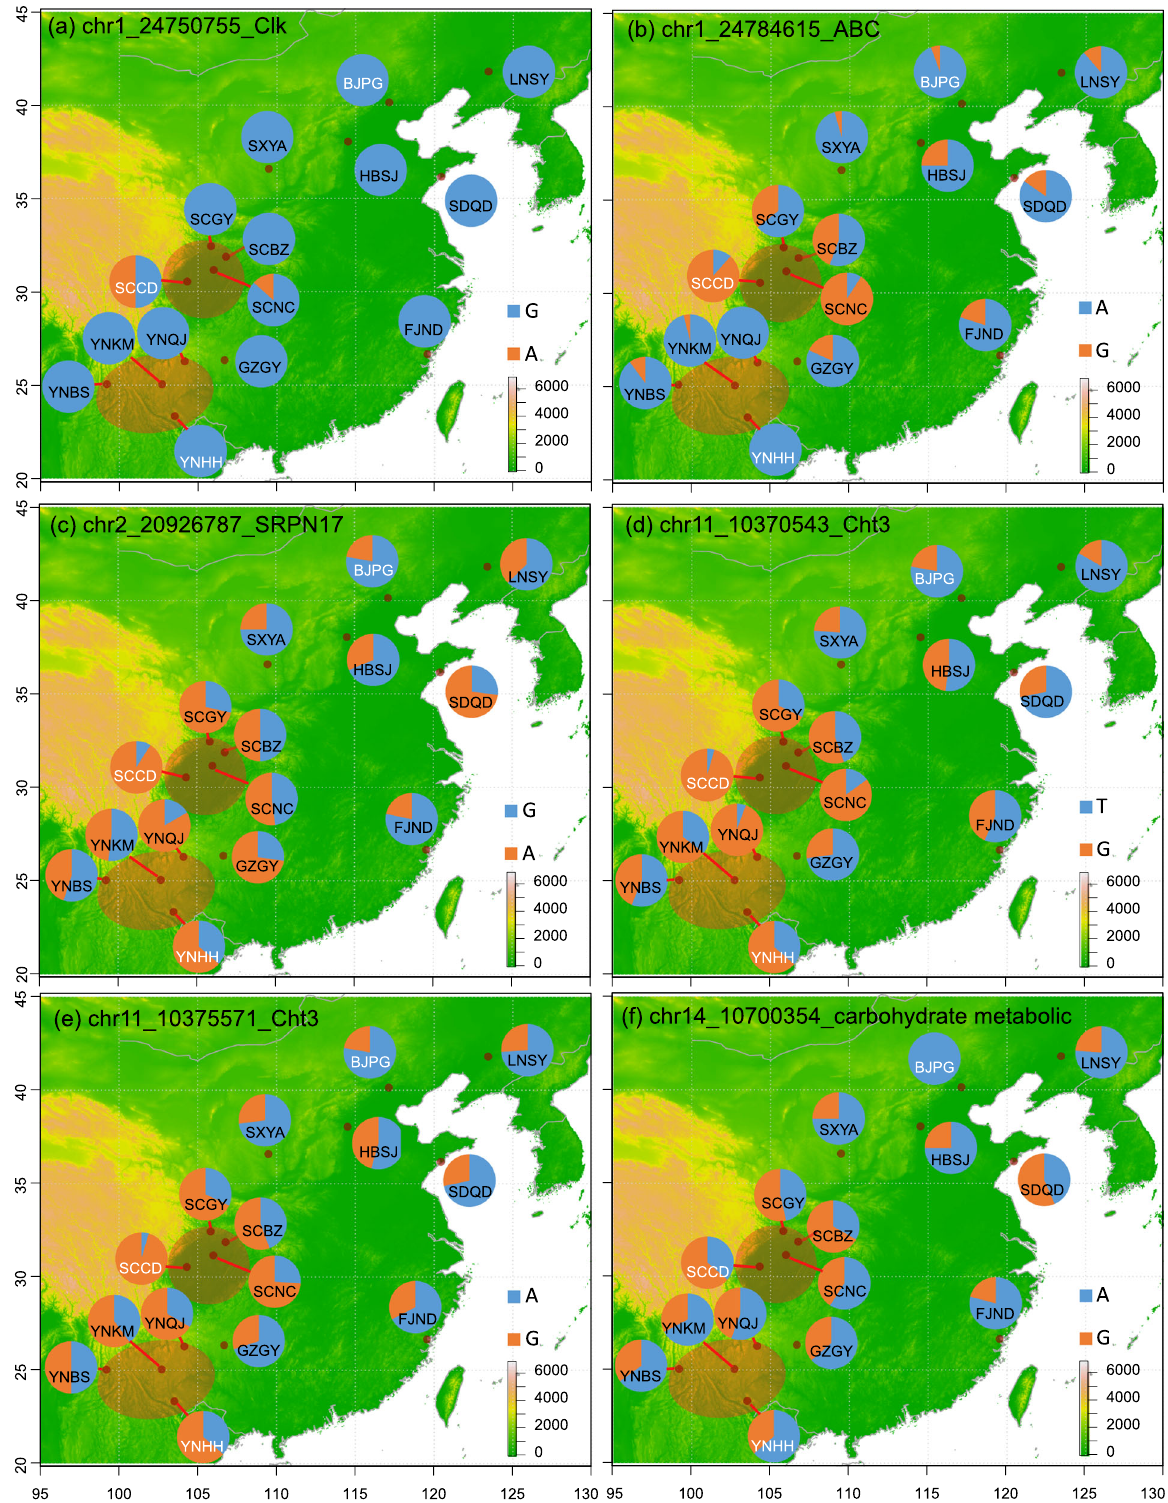
Fig. 3 Location and allele frequency of the fi fteen populations of the oriental fruit moth Grapholita molesta used in the study. The subtitles represent chromosome ID, the position of SNP, and gene name or function. Population code in white letters was genotyped by resequencing, while black ones were genotyped by KASP (Kompetitive Allele-Speci fi c PCR). The color of pie charts indicates the allele frequency of nucleotide of candidate SNPs across 15 populations. a – b SNPs putatively involved in endemicity; c – f SNPs putatively involved in northward